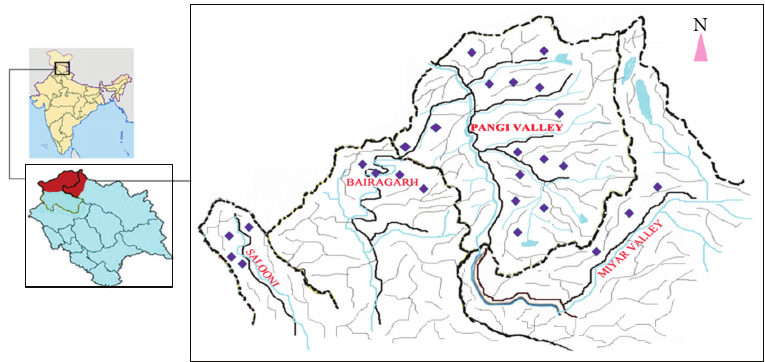
Figure 1: Location map of Pangi Valley in District Chamba (H.P.), Northwest Himalaya showing visited localities.